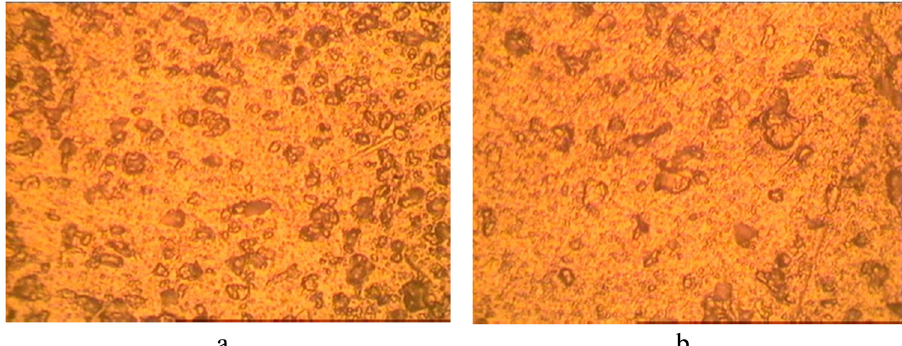
Figure 3: ( a ) Optical micrograph of Al - 6061/15SiC/5Gr at 200 × magni fi cation and ( b ) optical micrograph of Al - 6061/15SiC/5Gr at 400 × magni fi